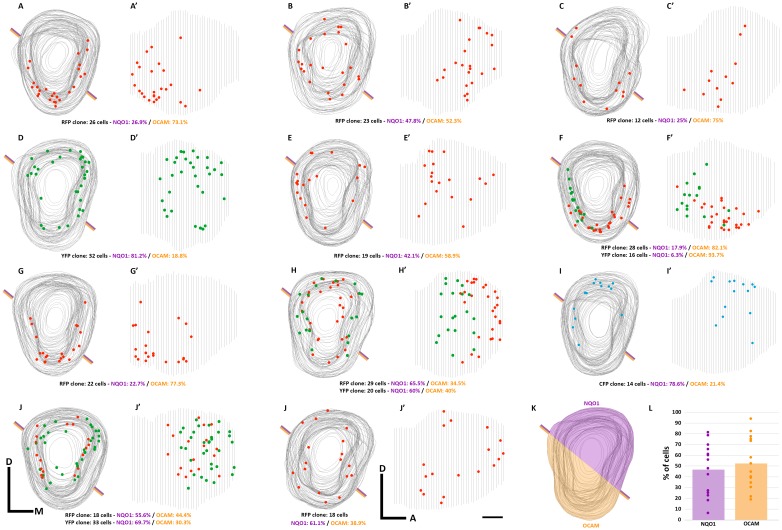
3D reconstruction of clones labeled in the olfactory bulb.(A–J) 3D reconstructions from 11 OBs showing the 14 OB clones analyzed in Figure 3. (A–J) Frontal and (A’–J’) lateral views of the OBs. (K) Division of the OB in the approximate NQO1 (purple) and OCAM (orange) domains based on the results shown in Cho et al. (2007) and Imamura et al. (2011). (L) Analyses of the clone distribution in the NQO1 and OCAM domains (purple and orange lines in each 3D reconstruction) for all the OB clones (p=0.67, t-test). Number of cells in each clone and their distribution in the approximate NQO1/OCAM domains is indicated in each 3D reconstruction. Scale bar in J’ is 0.5 mm and applies to A-J’. Orientation of diagrams: A, anterior; D, dorsal; M, medial.